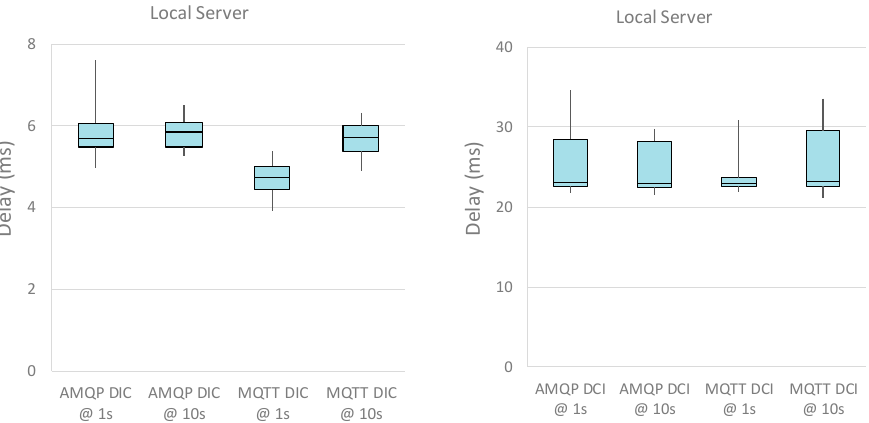
Figure 9. Boxplot of the DIC and DCI performance metrics with local server. The plot shows a blue box from the 25 percentile to the 75 percentile (with the median line). The whiskers go from the 5 percentile up the 95 percentile.